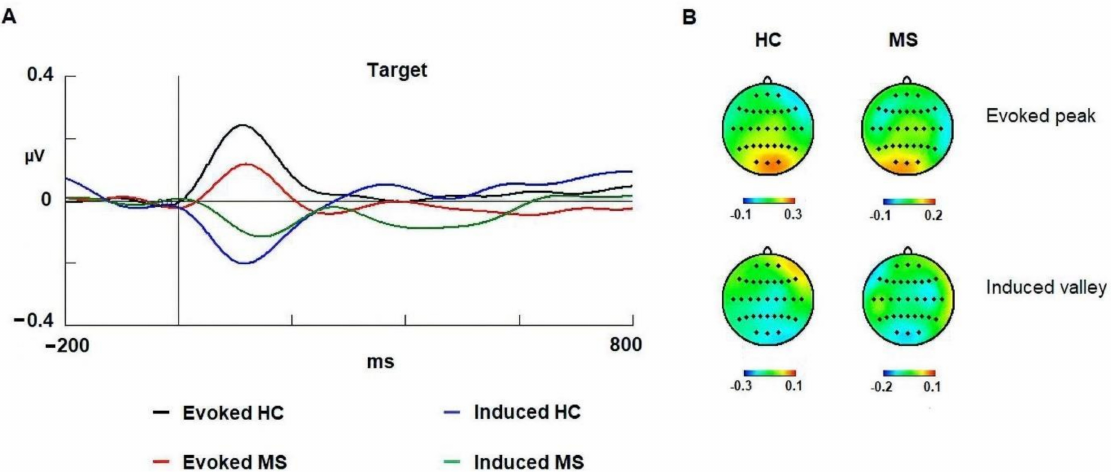
Figure 4. Spectral activity of gamma band in both groups. ( A ) Evoked and induced waves for the gamma band (30–45 Hz) in the visual oddball task. ( B ) 2D head maps for the peak and valley latencies of evoked and induced activity. Abbreviations: MS: multiple sclerosis; HCs: healthy controls; ms: milliseconds; µ V: